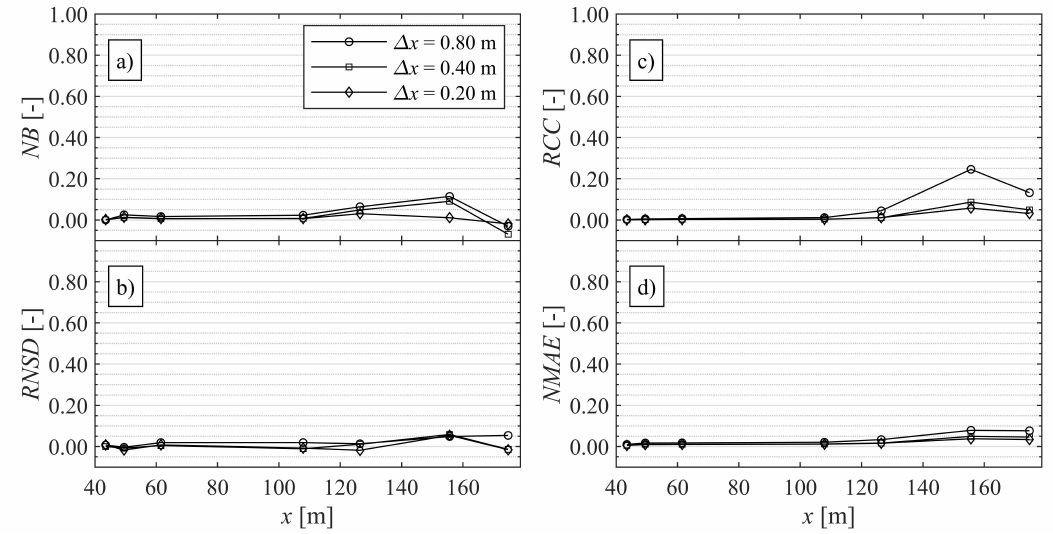
Figure A2. Same as Figure A1 but for the SW1L model grid resolution convergence analysis. See caption of Figure A1 for the description of ( a – d ). The reference is the finest grid model result with a horizontal grid cell resolution of ∆ x = 0.10